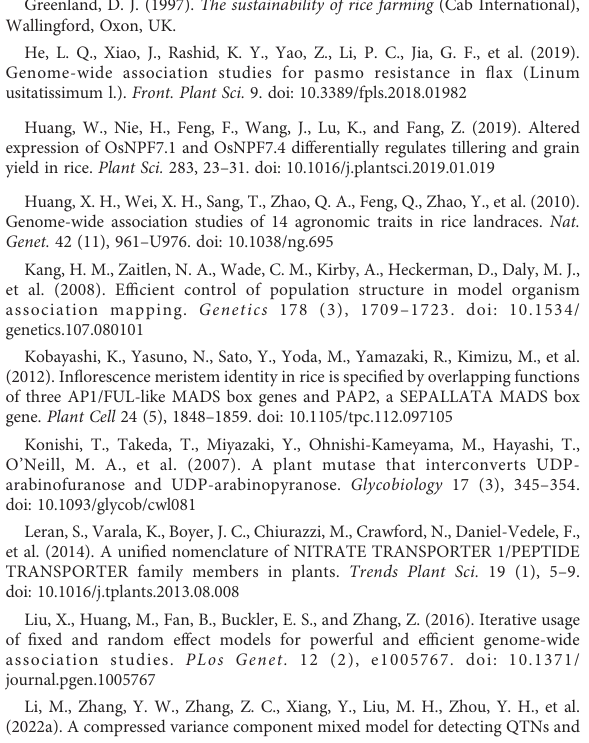
SUPPLEMENTARY FIGURE 3 Results of haplotype and phenotypic difference analysis for the